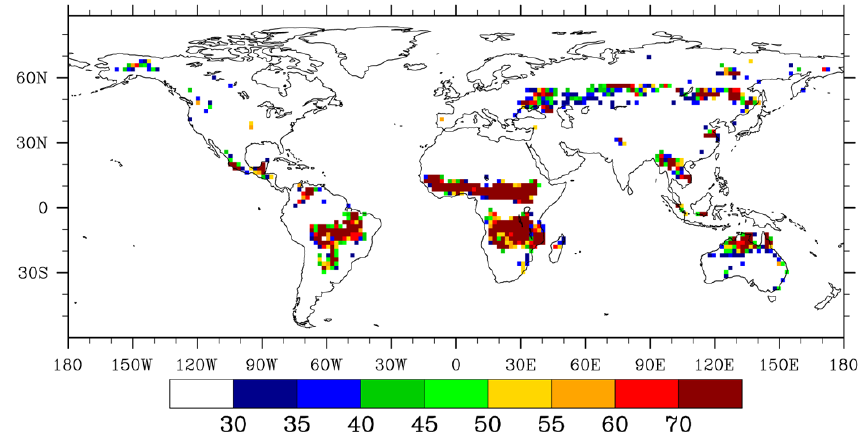
Fig. 1. MODIS active fire counts (count (1000km 2 ) − 1 mon − 1 ) in the peak month of each year averaged over 2001–2009. 1000km 2 are representative area set by CTEM-FIRE. Regions where value > 30count (1000km 2 ) − 1 mon − 1 represent regions of more than 1count (1000km 2 ) − 1 day − 1